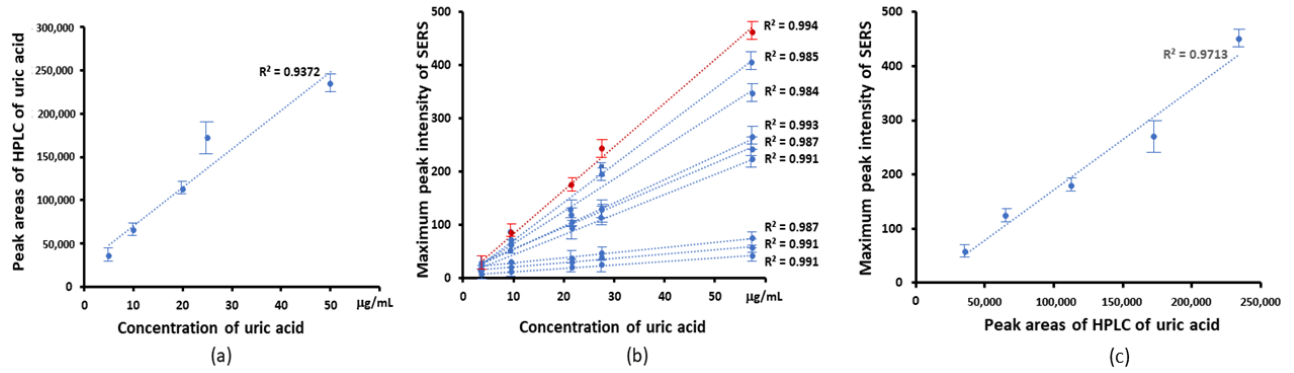
Figure 4. Linear correlation of HPLC and SERS with the concentration of uric acid conentration. ( a ) The linear correlation of HPLC peak areas with concentration of uric acid. ( b ) The maximum peak intensity of SERS vs . the concentration of uric acid. The linear correlation from top to bottom is maximum peak at 1000, 442, 1436, 1085, 1343, 1560, 802, 1206, 712 cm − 1 to concentration of uric acid. The peak at − 1000 cm − 1 (red line) showed a linear concentration with. R 2 of 0.994 ( c ) The linear correlation of the maximum peak intensity of SERS and peak areas of HPLC of uric acid. R 2 was 0.971.